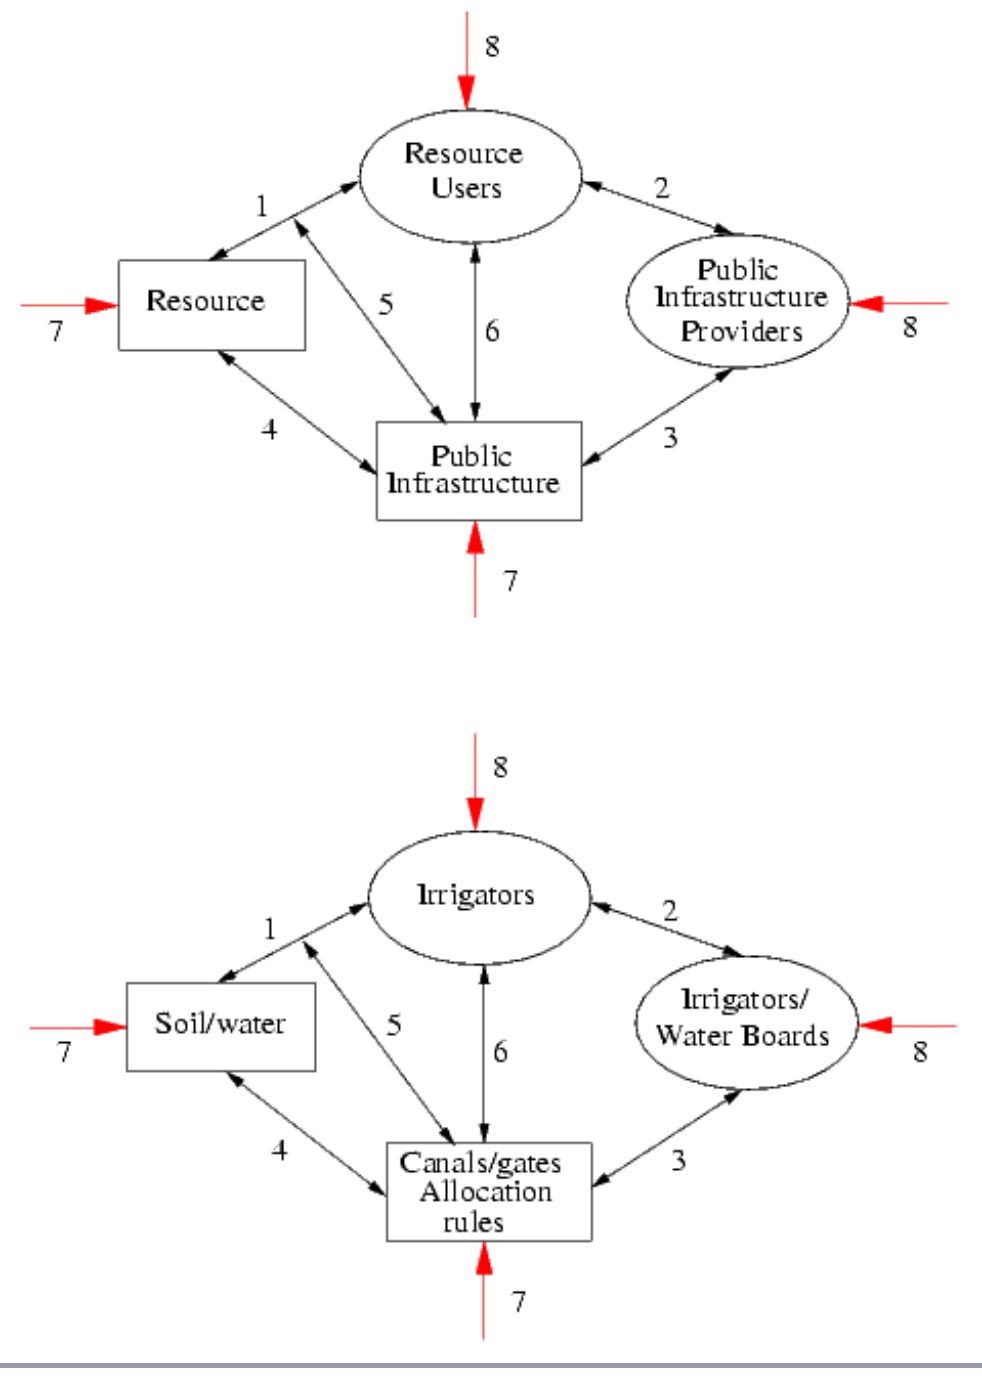
Fig. 1 . (A): General robustness framework (adapted from Anderies et al. 2004). (B): Specific instance of the framework for an irrigation system. The numbers on the arrows are used for reference- see text for further